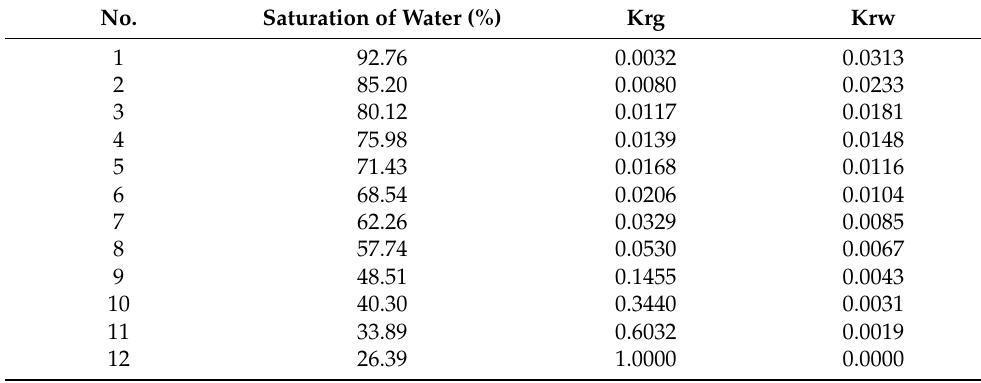
Table A5. The relative permeabilities of No.1 sandstone